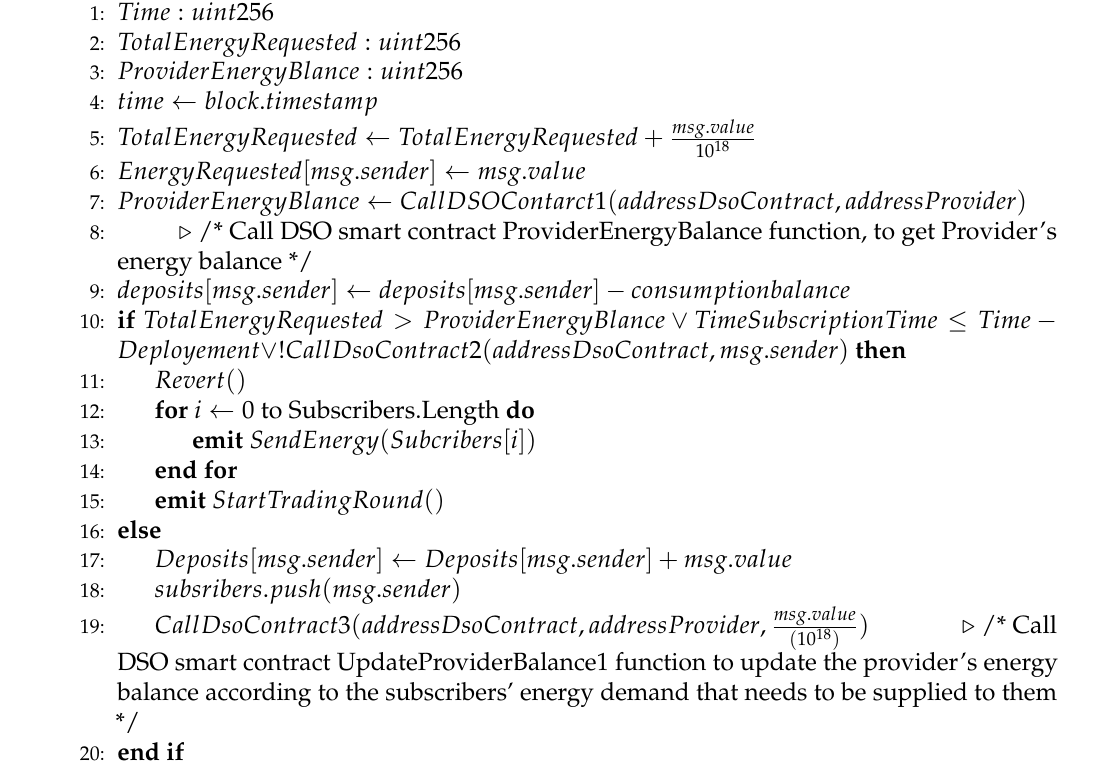
Algorithm 12 Provider’s Smart Contract: Subscribe